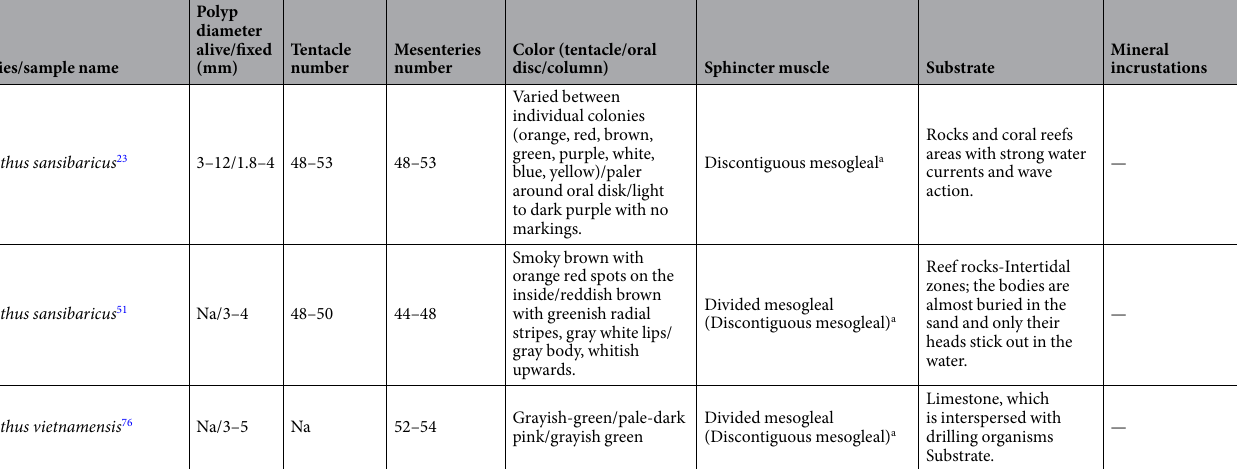
Table 1. Comparison of morphological and ecological characteristics of the species found at REMAPE with similar species described in previous studies. Species in bold were identified in this study. The word na = means not available. Na = data not available. a Evolutionary forms of the sphincter musculature, according to Swain 2015. * Duerden 1898, mentions a considerable contraction of the polyps in